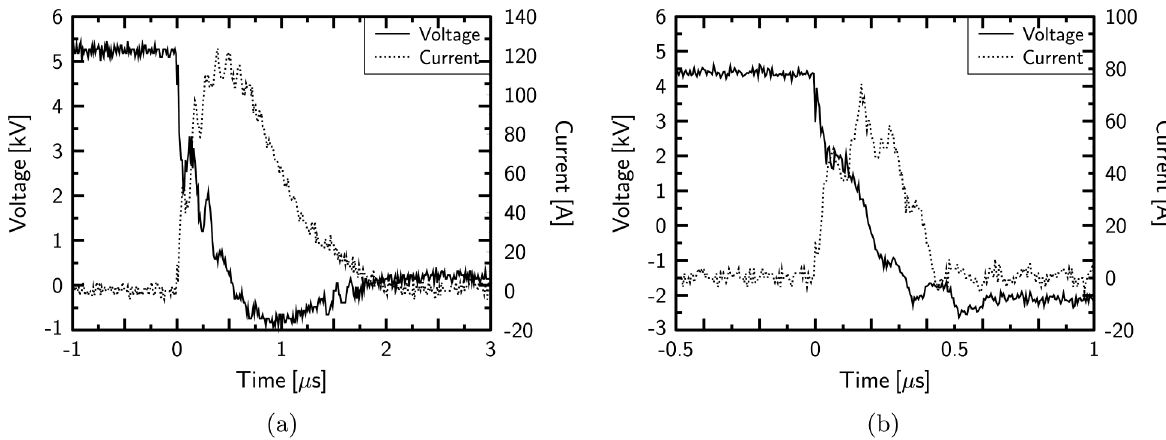
FIG. 3. Typical current-voltage characteristics for different energy regimes. Resonances limit the reliability of the signals. Note that negative voltages are an artifact of the measurement. (a) Cu, C 1 ¼ 15 nF . (b) Cu, C 1 ¼ 2 nF